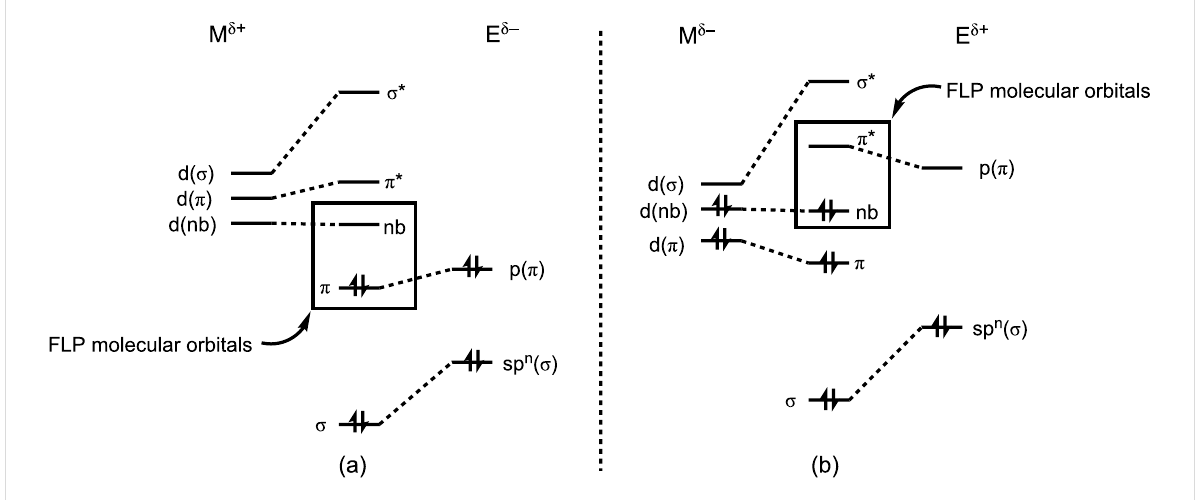
Figure 1: Simplified frontier-molecular-orbital diagrams for (a) M δ + ═ E δ− and (b) M δ− ═ E δ + FLPs ( n = 1 for linear or terminally bound species, e.g., nitride, carbyne, linear imide, oxo, or borylene; n = 2 for bent or trigonal species, e.g., carbene, silylene, bent imide, amide, or boryl).